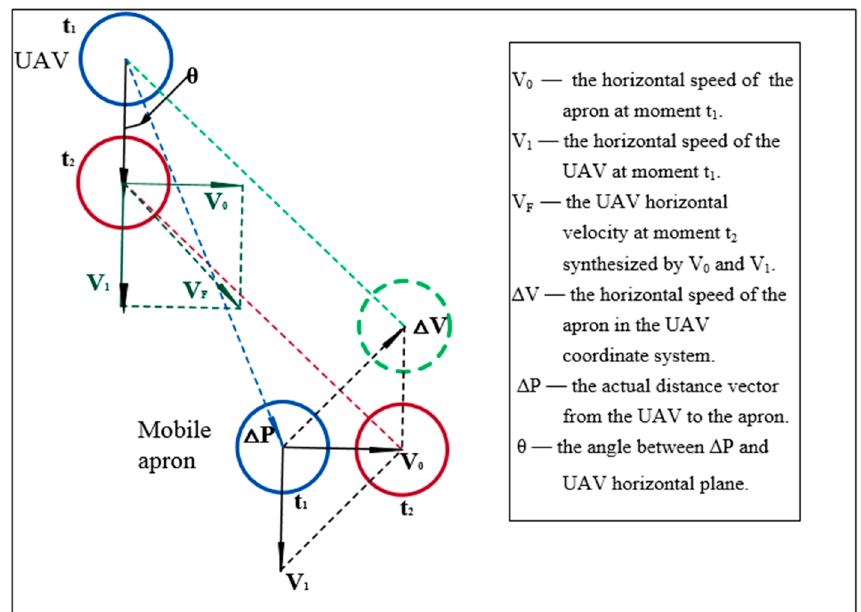
Figure 2. Triangular synthesis schematic diagram. The blue circle represents the UAV and the apron at time t 1 . The red circle represents the UAV and the apron at time t 2 , and the green dotted circle is the position of the apron in the UAV coordinate system. V 0 , V 1 , V F , ∆ V , and ∆ P are vector values, which contains both numerical values and directions. The horizontal speed of the UAV was synthesized by V F and ∆ V.